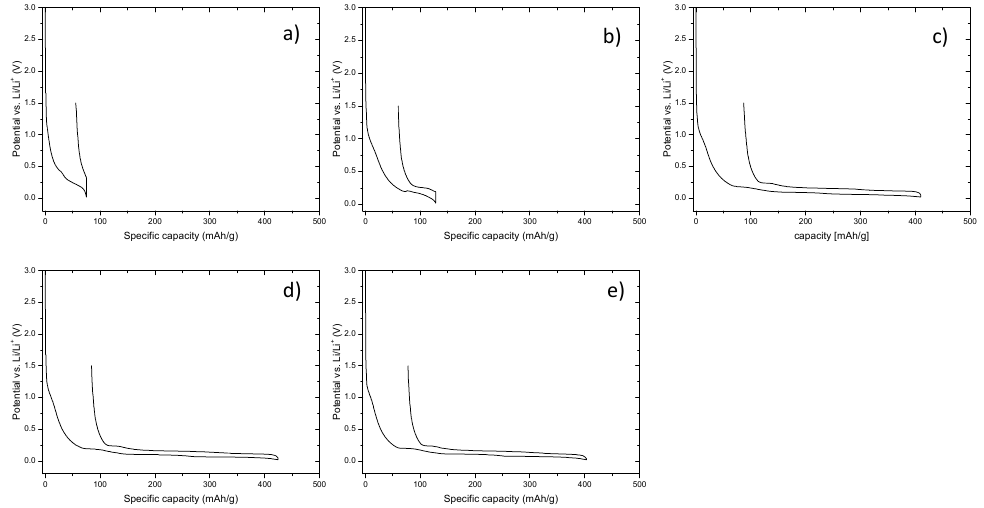
Figure 1. First cycle potential profiles of graphite/Li cells containing 1 M LiPF 6 in EMS with; ( a ) 0% FEC ( b ) 1% FEC, ( c ) 2% FEC; ( d ) 3% FEC and ( e ) 4% FEC, in the potential range from 0.02 to 1.5 V vs. Li/Li + .